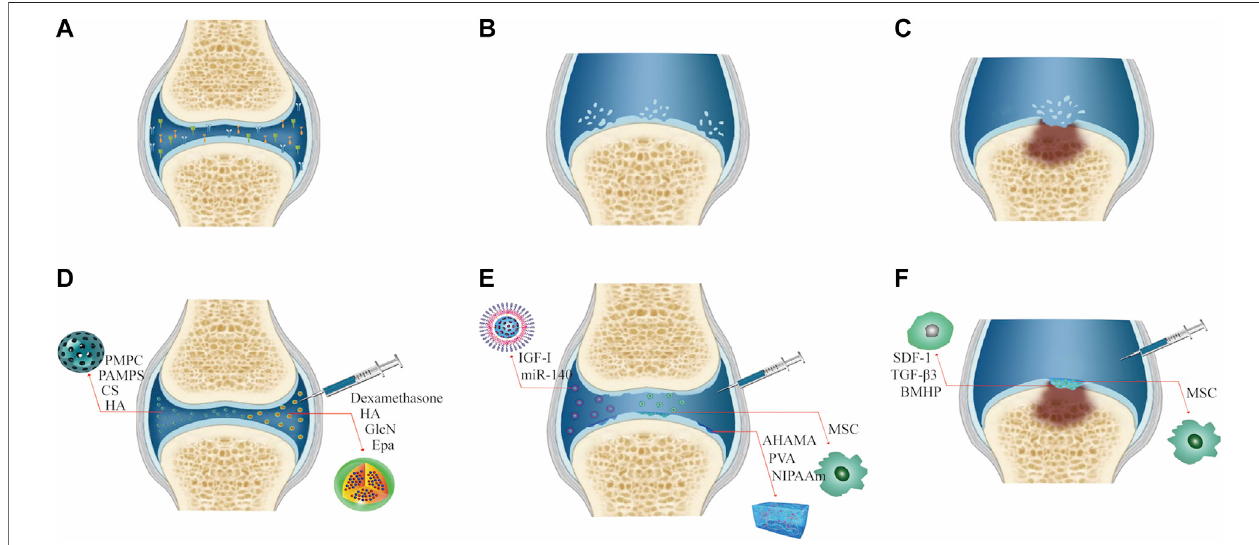
FIGURE 2 | Characteristics and treatment methods of different degrees of joint OA. (A) Early osteoarthritis. (B) Advanced osteoarthritis. (C) End-stage osteoarthritis. (D) Treatment of early osteoarthritis. (E) Treatment of advanced osteoarthritis. (F) Treatment of end-stage osteoarthritis.